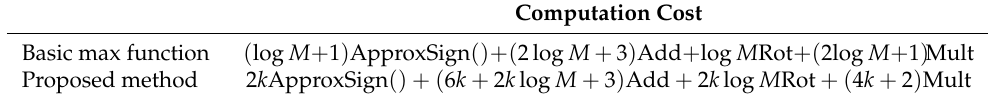
Table 4. Computational complexity comparison between the proposed method and the basic max